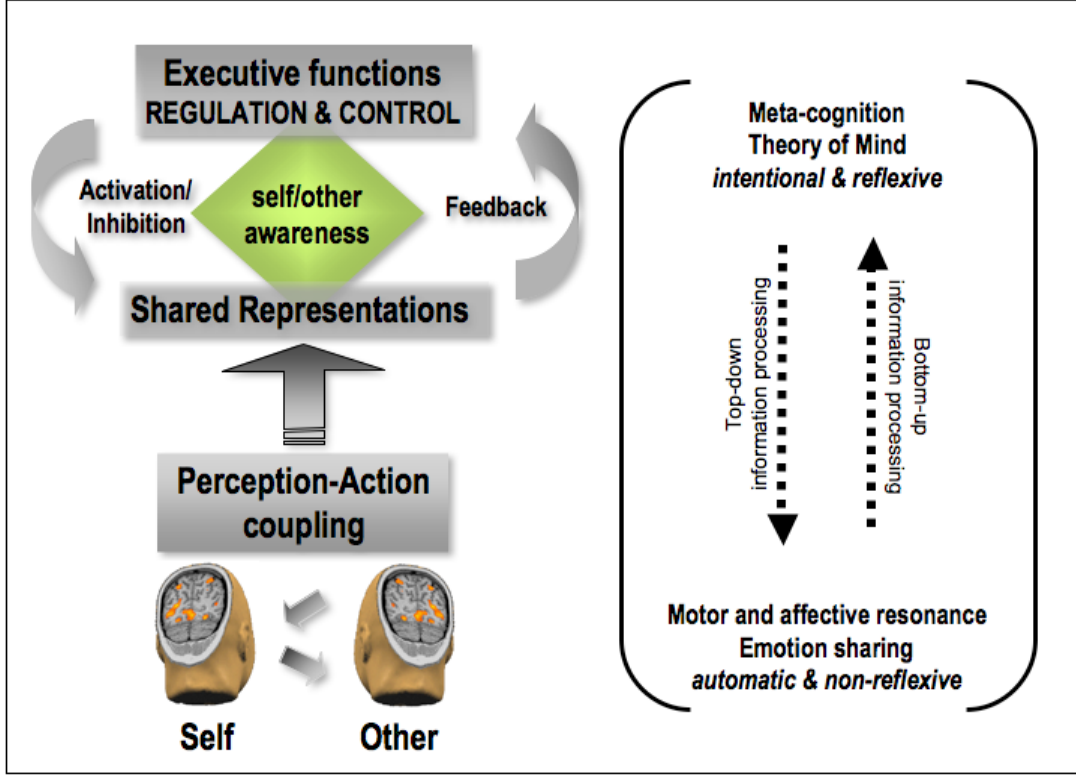
FIGURE 1 . Schematic representation of the bottom-up (i.e., direct matching between perception and action) and top-down (i.e., regulation and control) information processes involved in human empathy. These two levels of processing are interrelated. The lower level, which is automatically activated (unless inhibited) by perceptual input, accounts for emotion sharing, which leads to the implicit recognition that others are like us. Executive functions, implemented in the prefrontal cortex, serve to regulate both cognition and emotion, notably through selective attention and self-regulation. This meta-level is continuously updated by bottom-up information and, in return, controls the lower level by providing top-down input. Thus, top-down regulation, through executive functions, modulates low levels and adds flexibility, making the individual less dependent on external cues. The meta-cognitive feedback plays a crucial role in taking into account one’s own mental competence in order to react (or not) to the affective states of